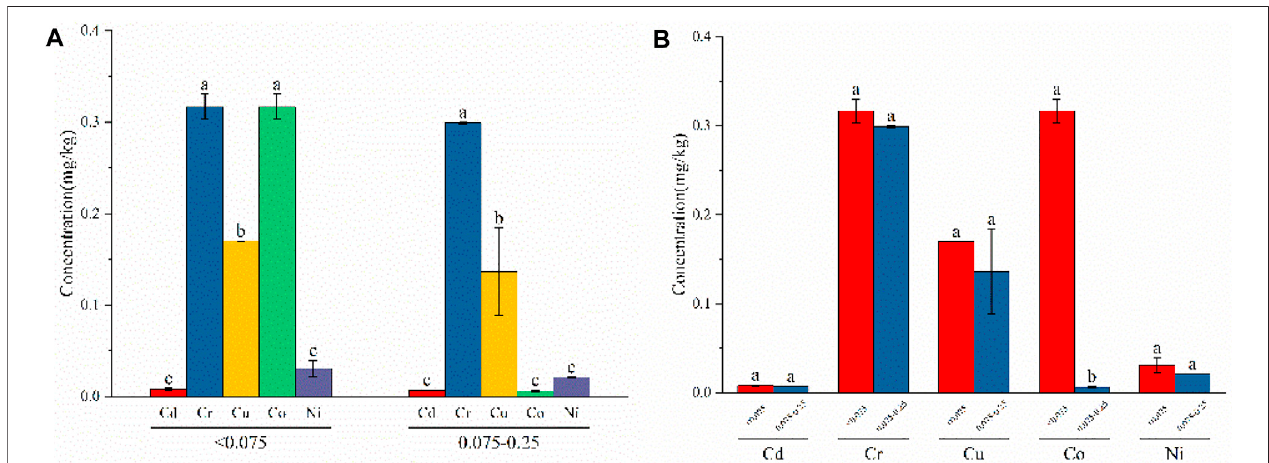
FIGURE 6 | Leaching concentration of heavy metals at different particle sizes conditions: (A) difference analysis of different heavy-metal element leaching concentrations under the same particle size conditions; (B) difference analysis of different particle size leaching concentrations under the same heavy-metal element condition.